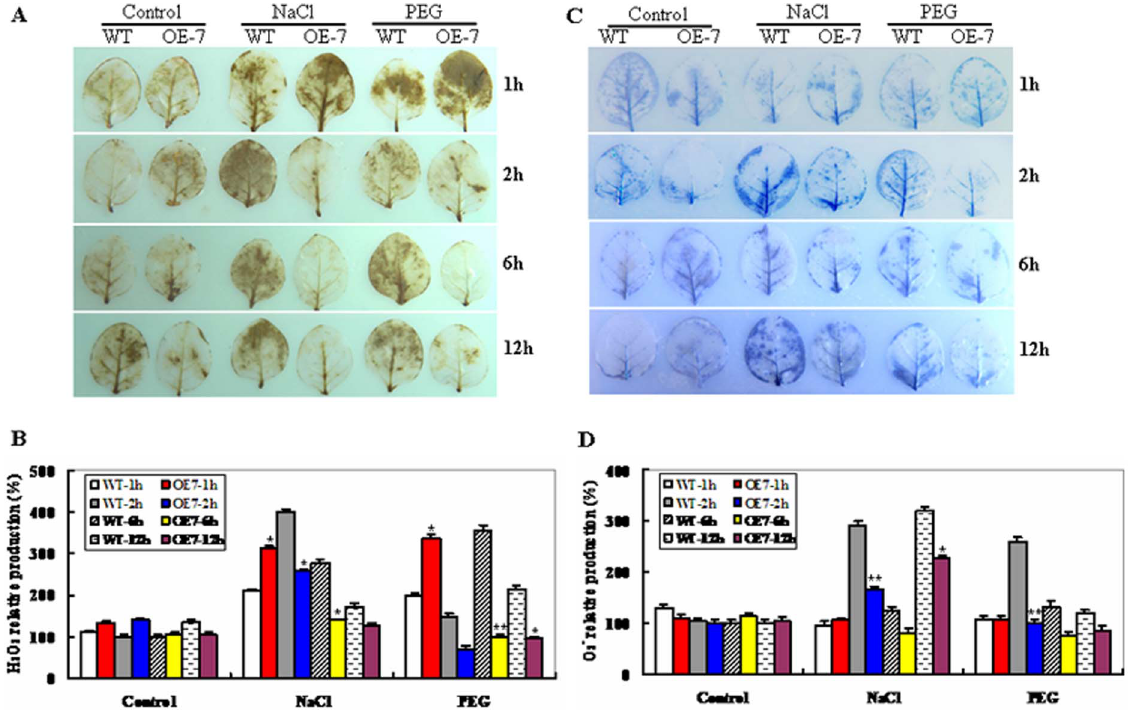
Figure 5. Dynamic changes of ROS in wild-type and ZmSKD1 -overexpressing tobacco plants in response to salt or PEG-induced water stress. A H 2 O 2 production in leaves of wild-type and OE (OE-7) plants treated with distilled water(control), 200 mM NaCl or 15% PEG-6000 solutions, respectively, was visualized by staining with 3, 3 9 -diaminobenzidine (DAB). Plants were treated for 1, 2, 6, and 12 h, and were subsequently stained with DAB as described in the experimental procedures. B Relative H 2 O 2 levels were quantified in leaves of wild-type and OE (OE-7) plants exposed to 200 mM NaCl or 15% PEG-6000 for 1, 2, 6, and 12 h. Error bars indicate SE (n=6). **t-test, with P , 0.01; *t-test, with P , 0.05. C O 2 2 production in leaves of wild-type and OE (OE-7) plants treated with 200 mM NaCl or 15% PEG-6000 solutions, respectively, was visualized by staining with nitroblue tetrazolium (NBT). Plants were treated for 1, 2, 6, and 12 h, and were subsequently stained with NBT as described in the experimental procedures. D Relative O 2 2 levels were quantified in leaves of wild-type and OE (OE-7) plants exposed to 200 mM NaCl or 15% PEG-6000 for 1, 2, 6, and 12 h. Error bars indicate SE (n=6). **t-test, with P , 0.01; *t-test, with P , 0.05.